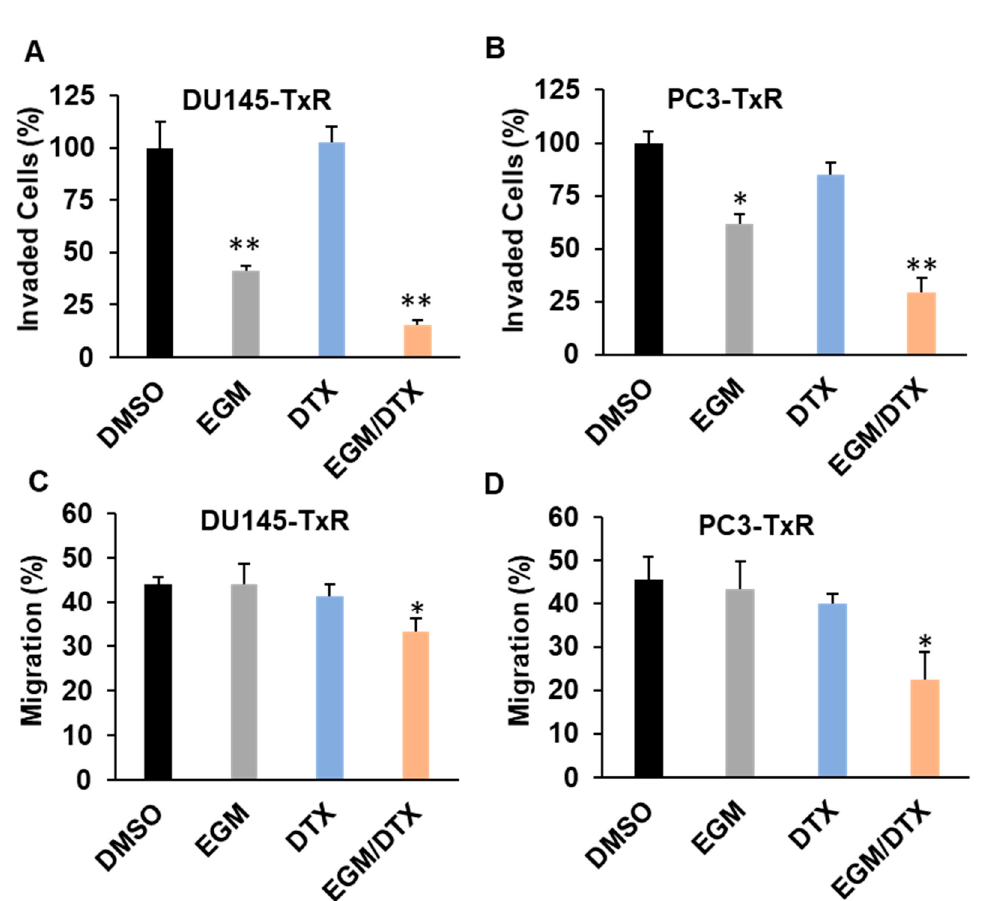
Figure 2. Eggmanone decreases invasion but not migration of chemo-resistant prostate cancer cells. ( A , B ) Effects of Eggmanone (EGM, 3 µM), Docetaxel (DTX, 1 nM) and their combination (3 µM EGM/1 nM DTX) on invasion of the chemo-resistant prostate cancer DU145-TxR and PC3-TxR